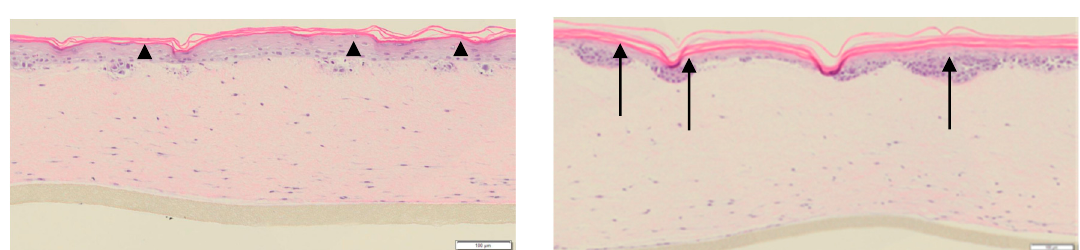
Figure 6. MatTek Melanoma skin model (MLNM-FT-A375) cultivation without treatment. Day 0 (left) and day 12 (right) of cultivation in our labs. Short arrows indicate the incorporated A375 cells; long arrows indicate some of the melanoma cell clusters at the epidermal–dermal junction, H&E staining, 10× magnification; scale bar 100 μ m.